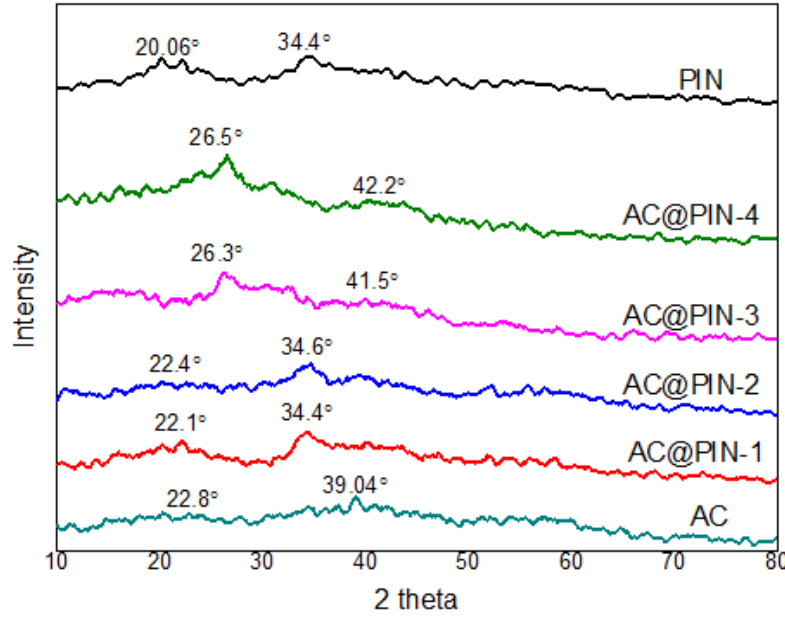
Figure 4. Comparison of XRD pattern of PIN and PIN@AC composites.